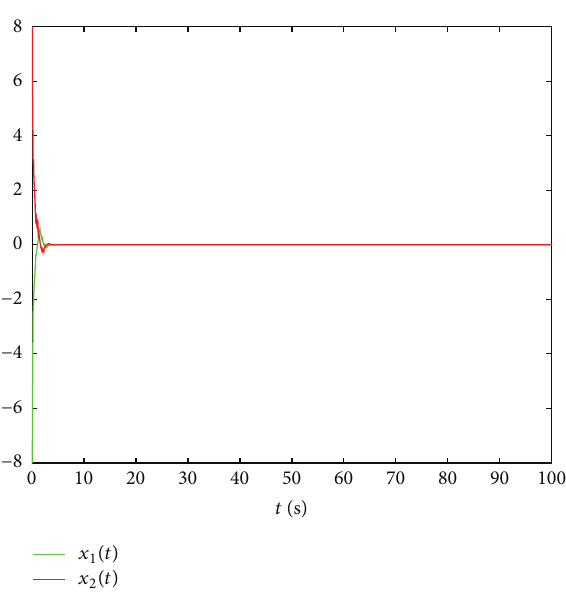
Figure 2: The mean-square exponential stability with the initial value as 𝑥 0 = [−8,8]